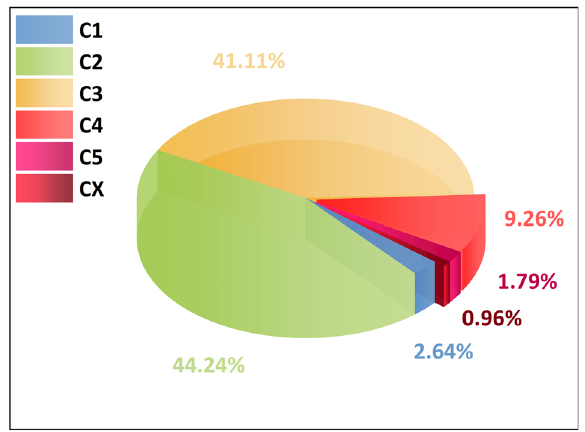
Fig. 2 Results of corrosion categories of galvanized steel according to ISO 9223. The atmospheric environments are dividing into six categories, from low to high, are C1, C2, C3, C4, C5, and CX,